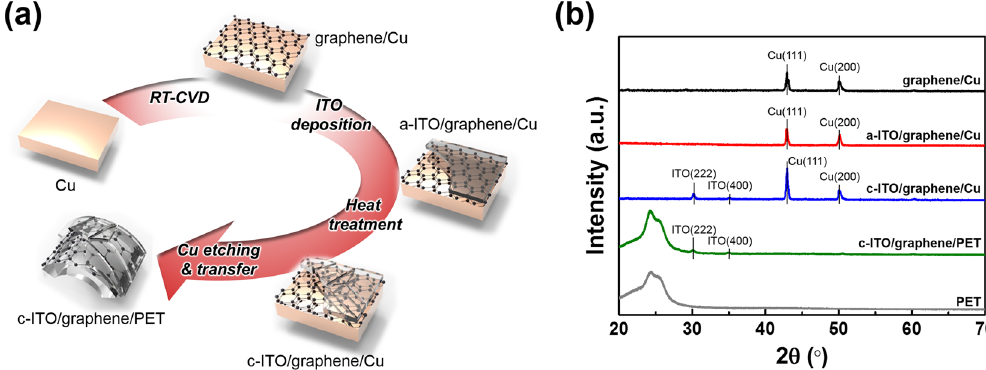
Figure 1. ( a ) Schematic diagram of the fabrication of a c-ITO/graphene/PET film. ( b ) XRD patterns obtained at each step during the preparation of the graphene-supported c-ITO film. The bottom XRD pattern was obtained from the PET film as a